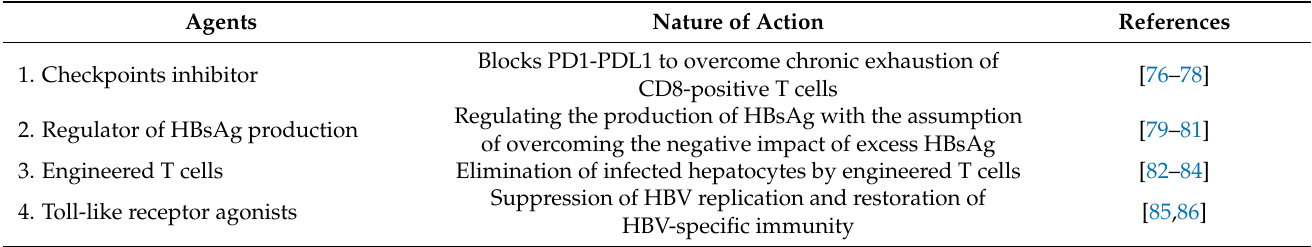
Table 4. Immune therapy targets the revival of host immunity.